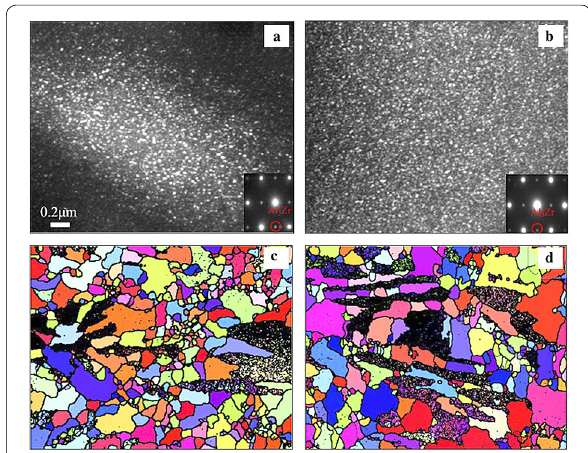
Figure 6 Precipitation characteristics of the Al 3 Zr phase after a single homogenization (510 °C/24 h) and b two-stage homogenization (460 °C/12 h 520 °C/24 h), and the recrystallization behavior + after hot deformation of c the single homogenized sample and